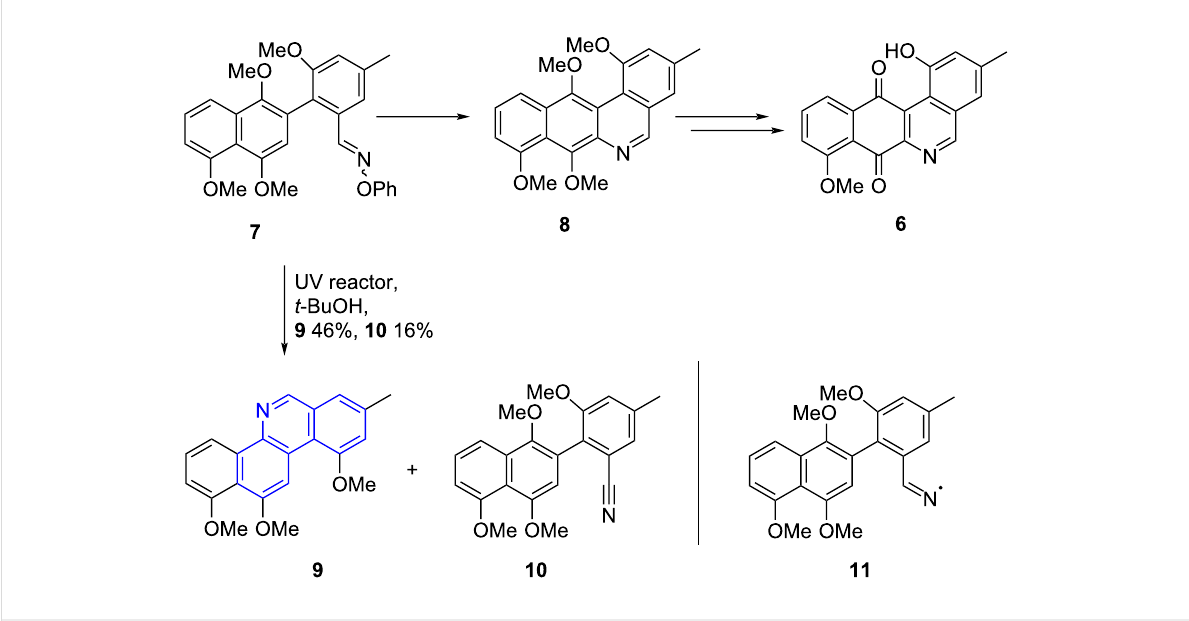
Scheme 1: Previous unexpected synthesis of the phenanthridine